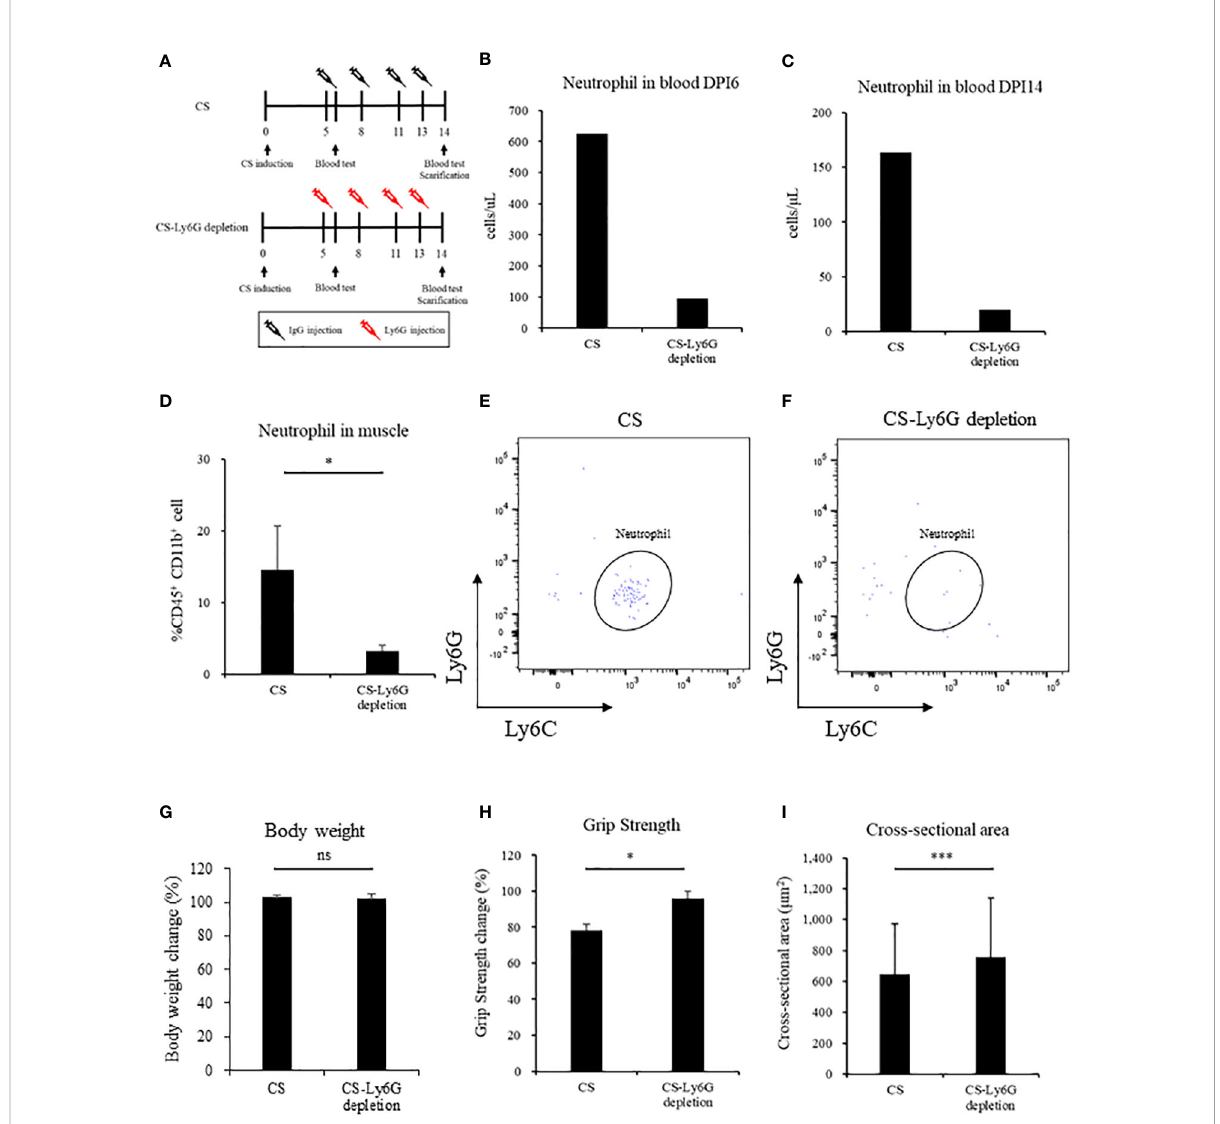
FIGURE 4 Neutrophil depletion reverses sepsis-induced muscle atrophy and weakness in mice. (A) Shema showing study design, (B, C) Number of neutrophil in blood in Day 6 and Day 14, (n = 1 in each group) (D) Percentage of neutrophils in muscle (n = 3 – 4 in each group), (E, F) FACS image 14 days after CS induction and CS-Ly6G depletion (n = 1 in each group) (G) Body weight 14 days after CS induction (H) Grip strength in 14 days after CS induction (I) Muscle cross-sectional area 14 days after CS induction. n = 5 in each group. Statistical signi fi cance versus CS at * P < 0.05, *** p < 0.001, ns = not signi fi cant ( p >